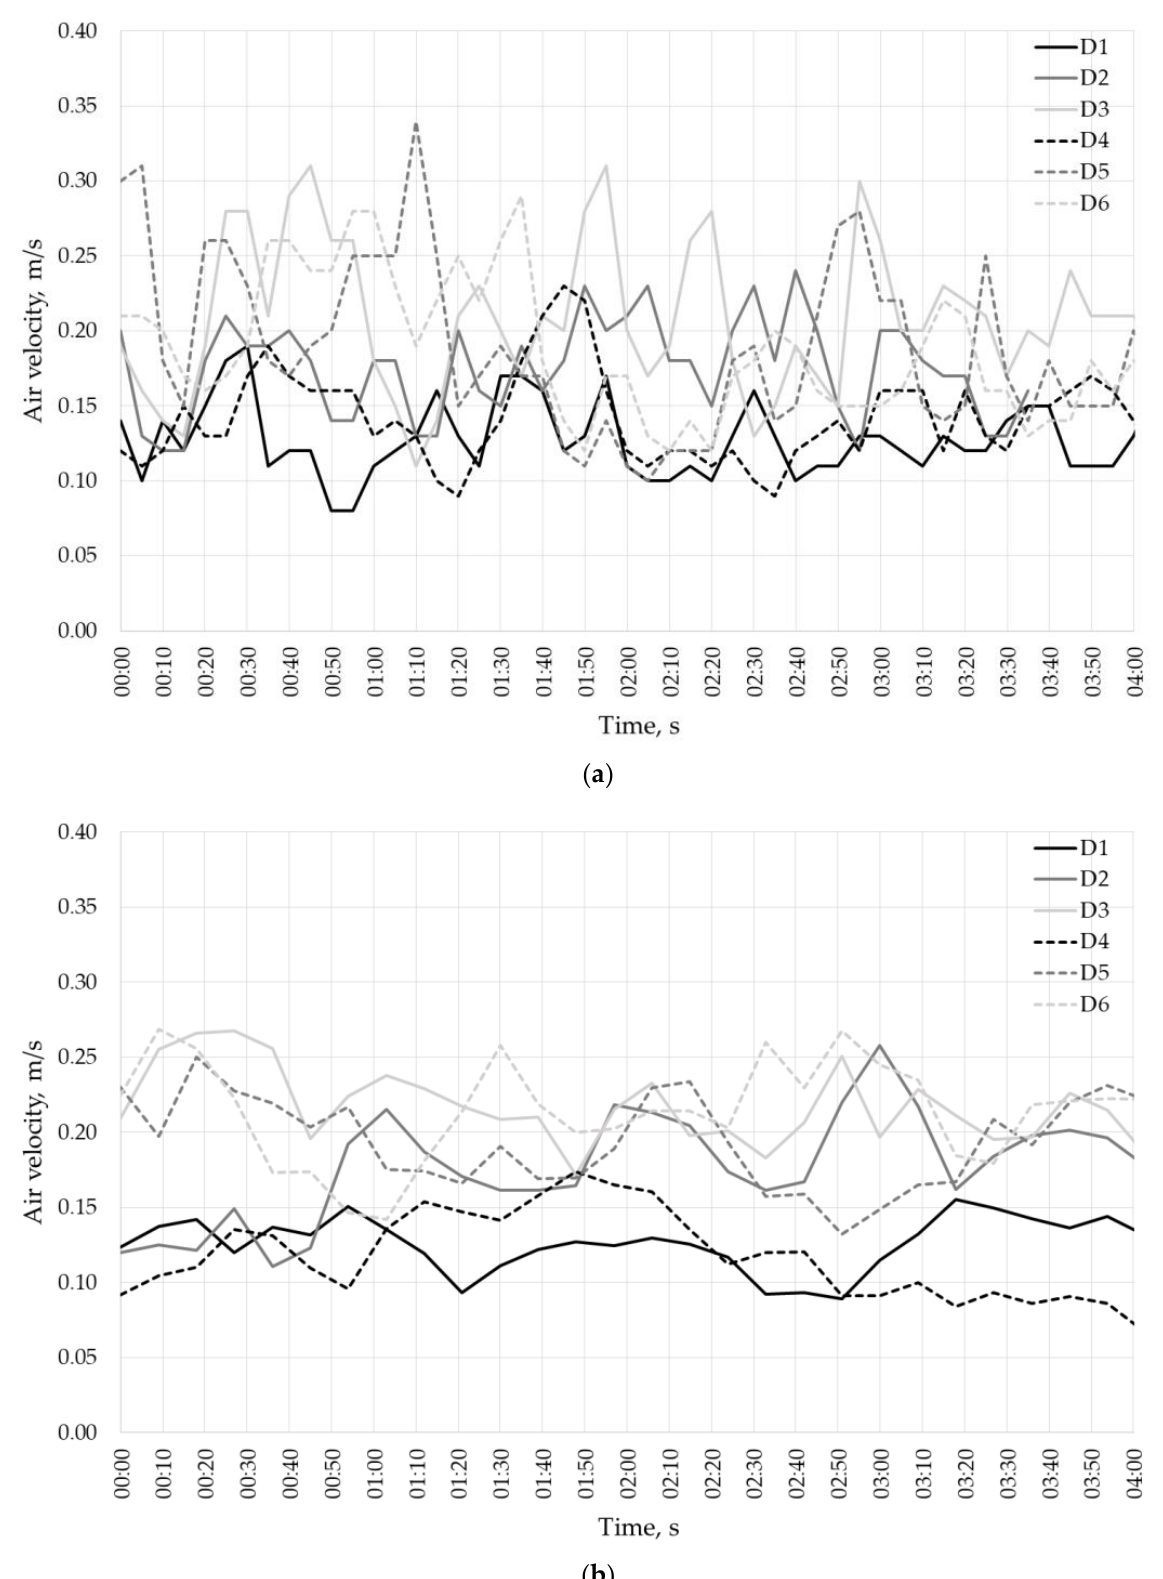
Figure 5. The air velocity on selected desks in time 4 min ( a ) for diffuser Type I; ( b ) for diffuser Type II.